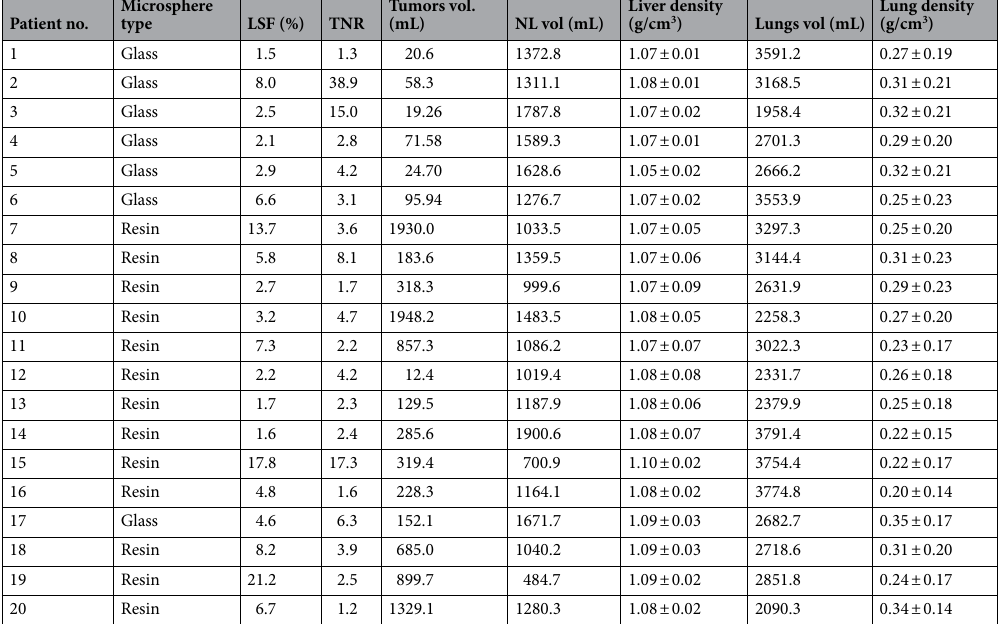
Table 1. Patient characteristics. LSF lung shunt fraction, TNR tumor to normal liver ratio, NL non-tumoral liver.